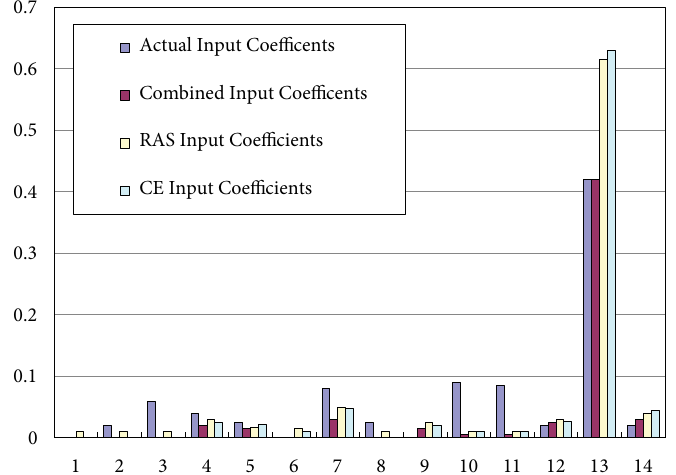
Fig. 4. Comparison of the combined estimated input coefficient and actual input coefficient for the Korean IT device manufacturing